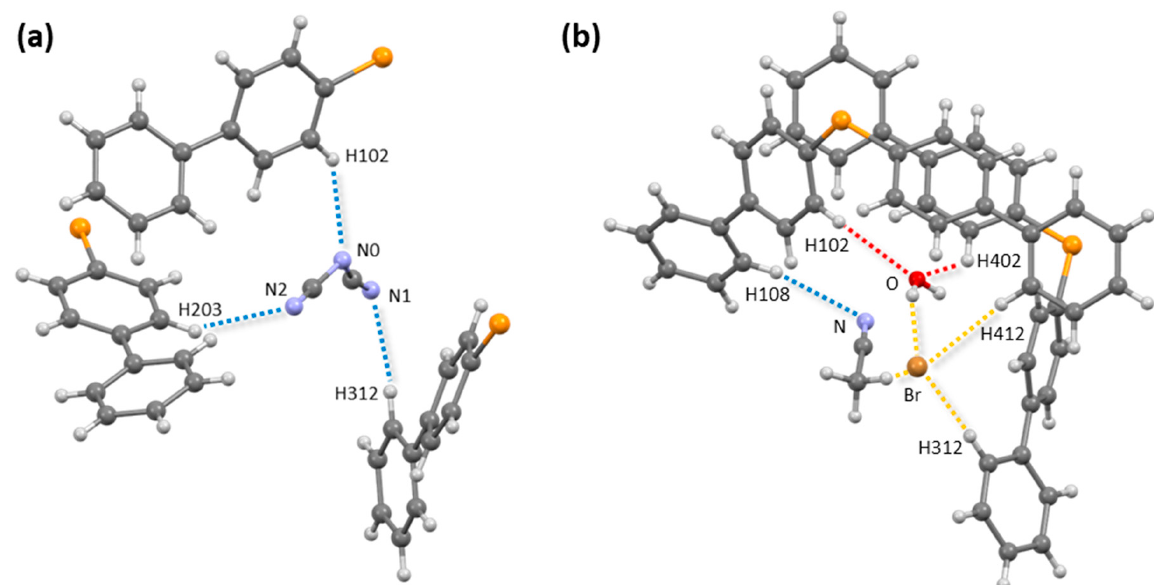
Figure 4. Ball-and-stick representation of intermolecular interactions involving N(CN) 2 − in com- pound 1 ( a ) and CH 3 CN, H 2 O, and Br - in compound 2 ( b ). C-H···N, C-H···O and C-H···Br close con- tacts are represented by blue, red and yellow lines, respectively.